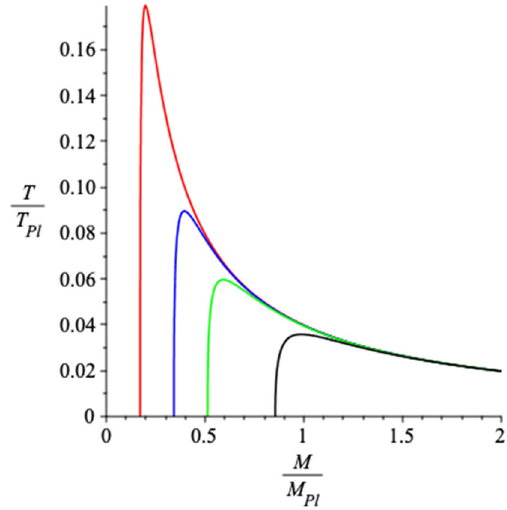
Fig. 4 The function T ( M ) for a standard RN black hole with n = 2 , 4 , 6 , 10 (left to right). The curves end at M = n sponding to a charged remnant with T = 0